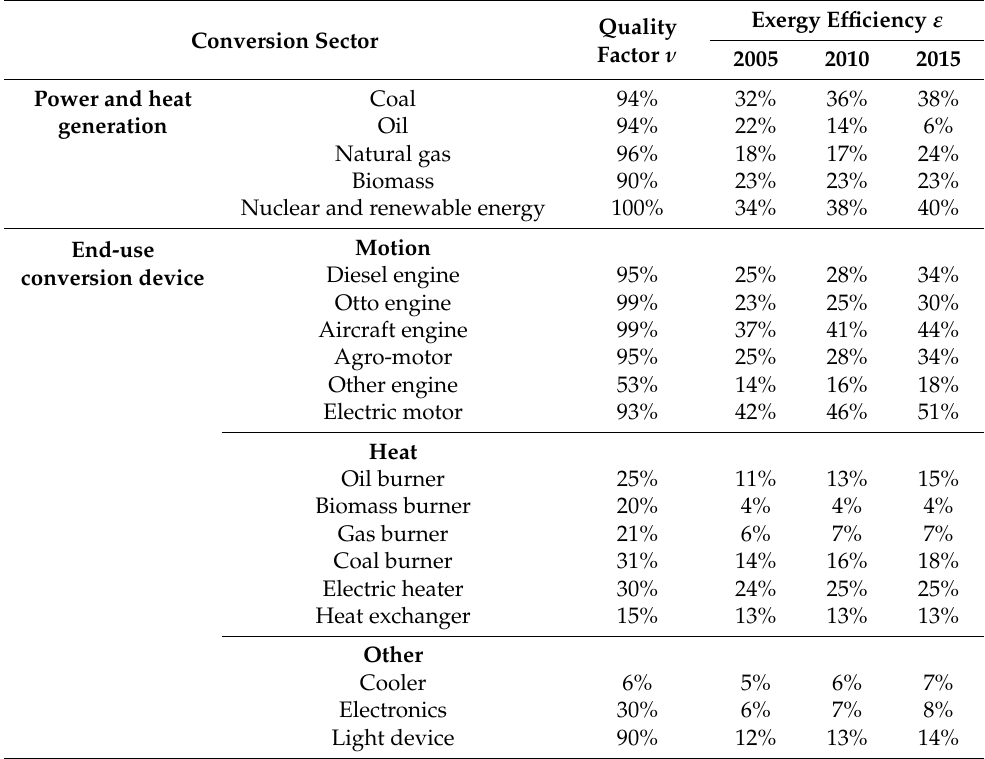
Table A4. Exergy efficiency of the end-use conversion device stage and the power and heat generation sector.